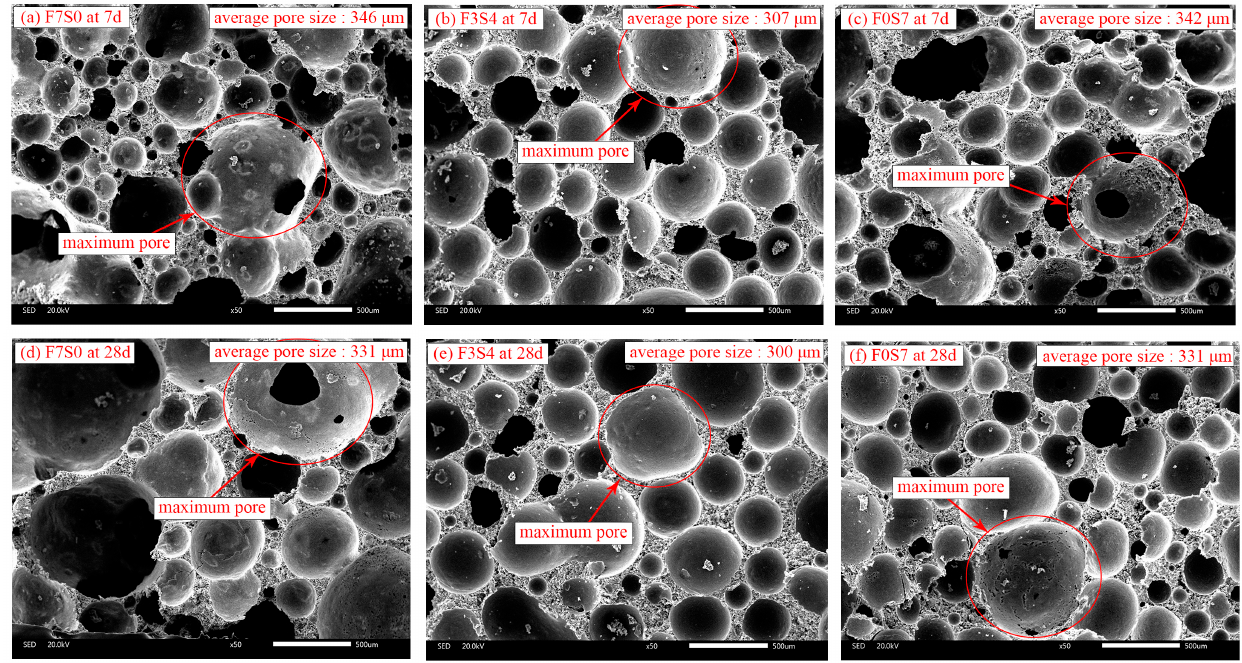
Figure 7. SEM images of the LCFLS at 50× magnification.